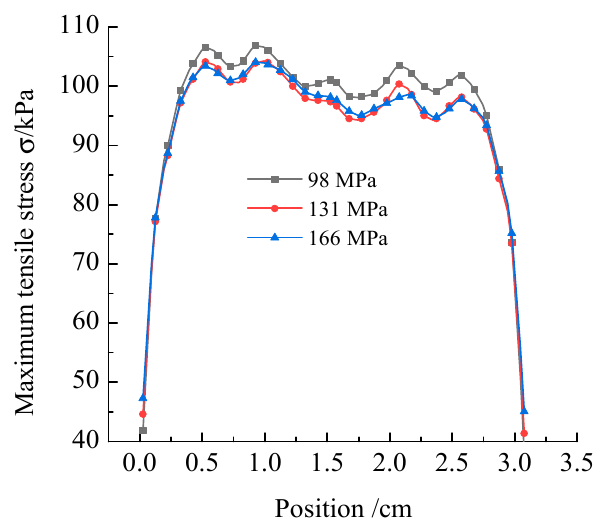
Figure 17. Variation of stress at the top of lifting layer under di ff erent moduli of elasticity polymer lifting.